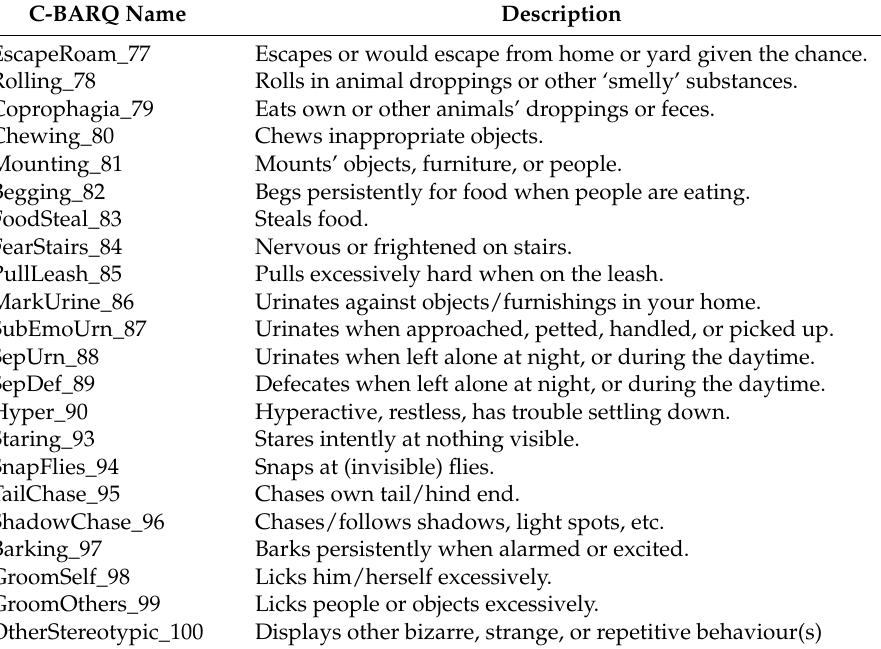
Table 2. Canine Behavioural Assessment and Research Questionnaire (C-BARQ) miscellaneous behaviours, reactions and